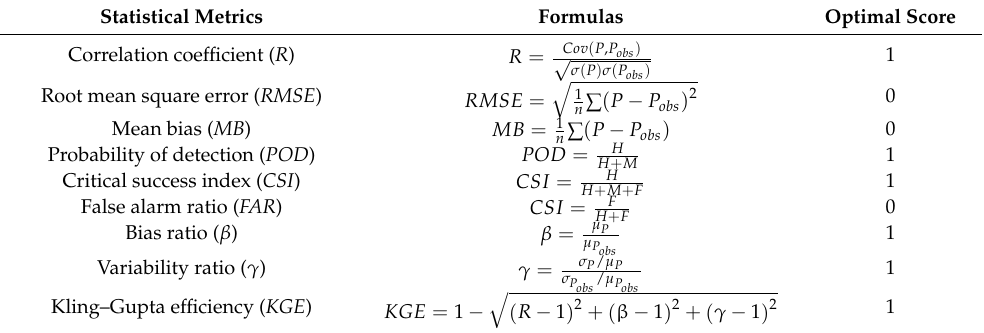
Table 2. Statistical metrics used for evaluating precipitation and runoff estimates. P is precipitation estimate; P obs is observation data; Q is runoff estimate; Q obs is observation runoff from the gauge; Cov is the covariance; σ is the standard deviation and µ is the mean value; n is the number of data pairs; H is the number of observed precipitation events detected correctly by the products; F is the number of precipitation events detected by the products but not observed; and M is the number of precipitation events that the products cannot